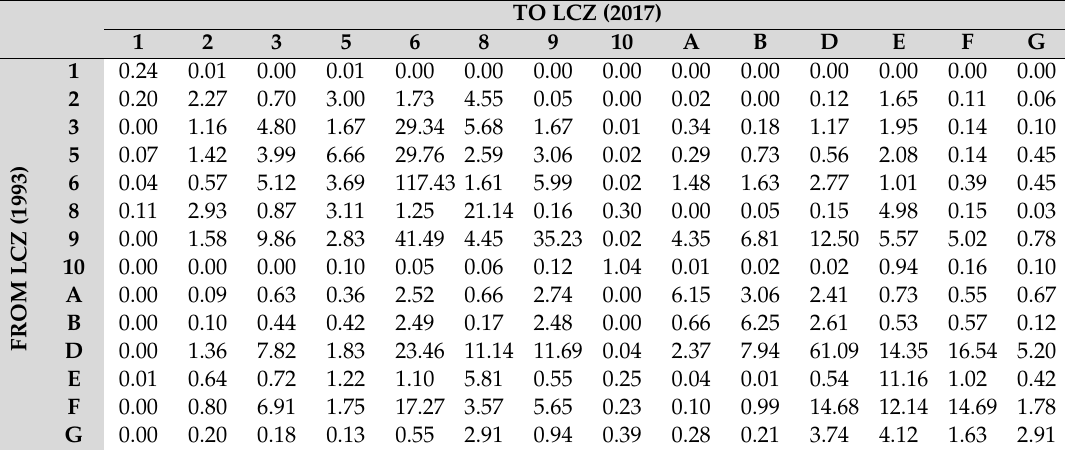
Table A3. Spatial extents (km 2 ) of transitions and no-change among LCZs from 1993 to